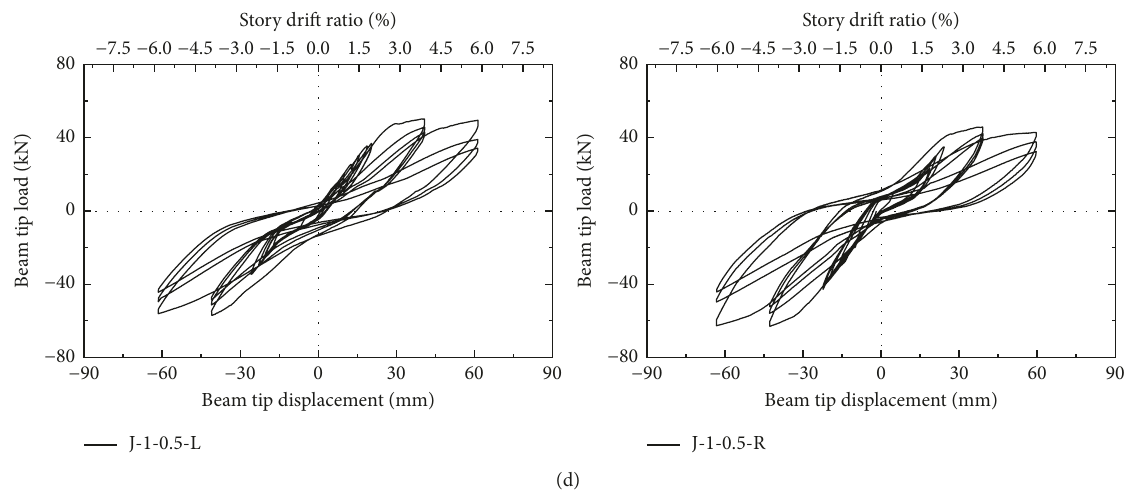
Figure 6: Hysteresis curve of joints. (a) Specimen J-0-0.3. (b) Specimen J-0-0.5. (c) Specimen J-1-0.3. (d) Specimen J-1-0.5.